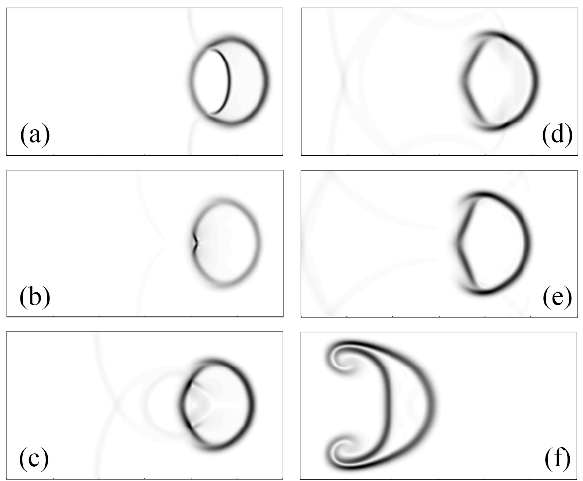
Figure 2. The schlieren-type images of density of the numerical results for shock bubble interaction (air-R22 interaction). ( a ) t = 115 µs; ( b ) t = 187 µs; ( c ) t = 247 µs; ( d ) t = 342 µs; ( e ) t = 417 µs; ( f ) t = 1020 µs.